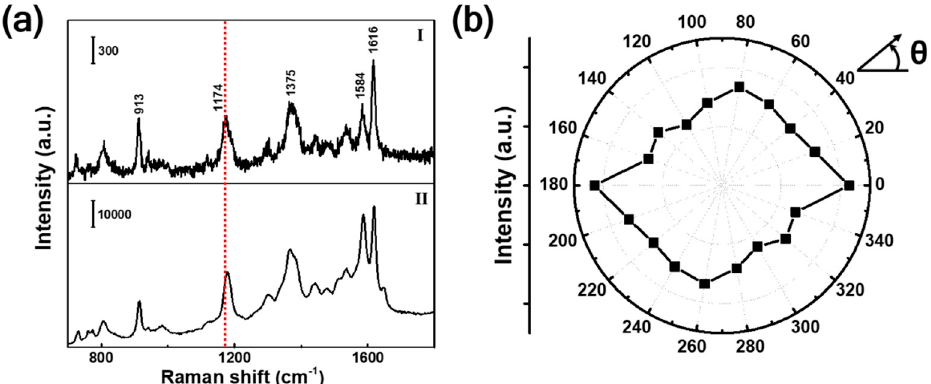
Figure 2. Surface-enhanced Raman scattering (SERS) measurements of the silver aggregates fabricated by 60 s exposure at a laser power of 0.9 mW. ( a ) Curve I: Raman spectrum of CV powder. Curve II: The SERS spectrum of CV adsorbed on the silver aggregates. ( b ) Polar plot of SERS intensity (1174 cm − 1 ) under different excitation polarizations ( θ ).